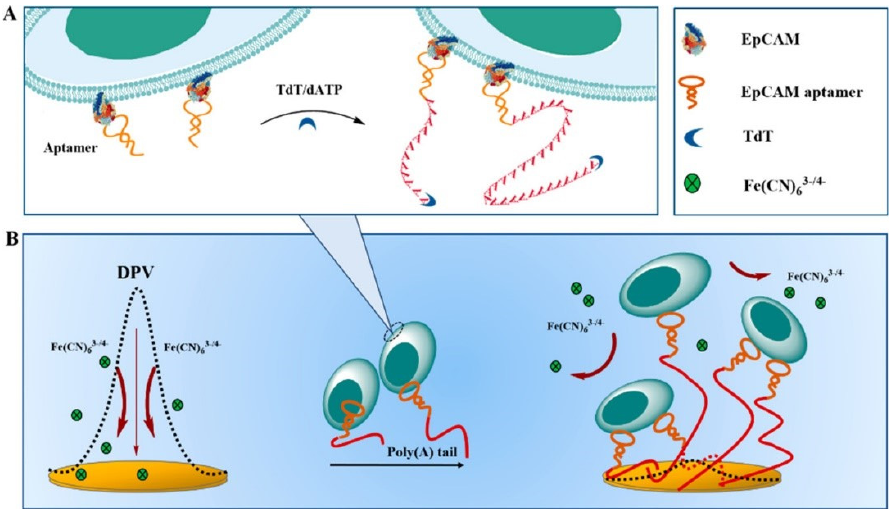
Figure 5. ( A ) The addition of polyadenine at the 3 ′ -OH terminus of the aptamers. ( B ) Schematic diagram of the strategy used for electrochemically detection. Reproduced with permission from [48], American Chemical Society, 2020.